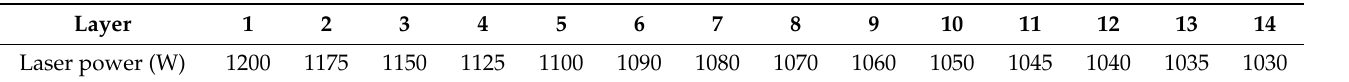
Figure 10. Scanning path comparison: ( a ) constant laser power in continuous scanning, ( b ) reduced laser power layer by layer in discontinuous scanning. Table 2. Numerical variation of power reduction step by step.